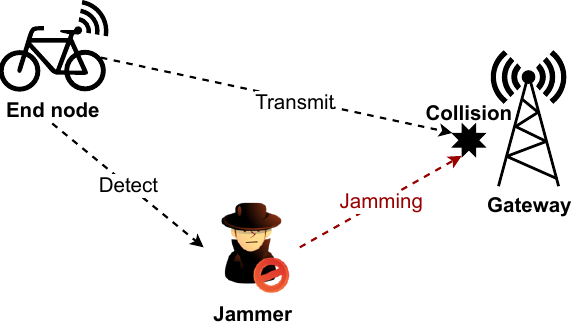
Figure 8. Example of jamming attack. Adapted from